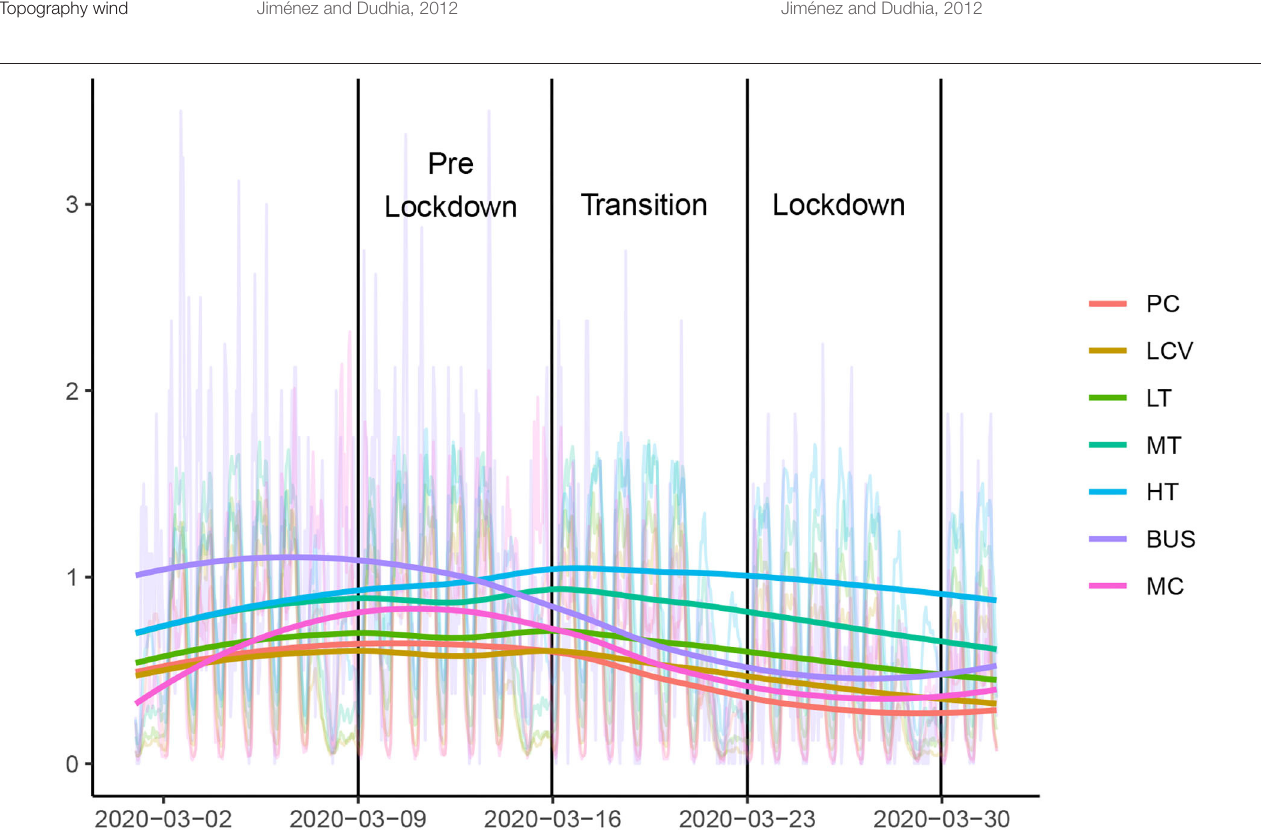
FIGURE 1 | Temporal factors for transportation volume in São Paulo in March 2020 including Passenger Cars (PC), Light Commercial Vehicles (LCV), Light Trucks (LT), Medium Trucks (MT), Heavy Trucks (HT), Buses (BUS), and Motorcycles (MC). Temporal factors are used to extrapolate the morning rush hour volume of